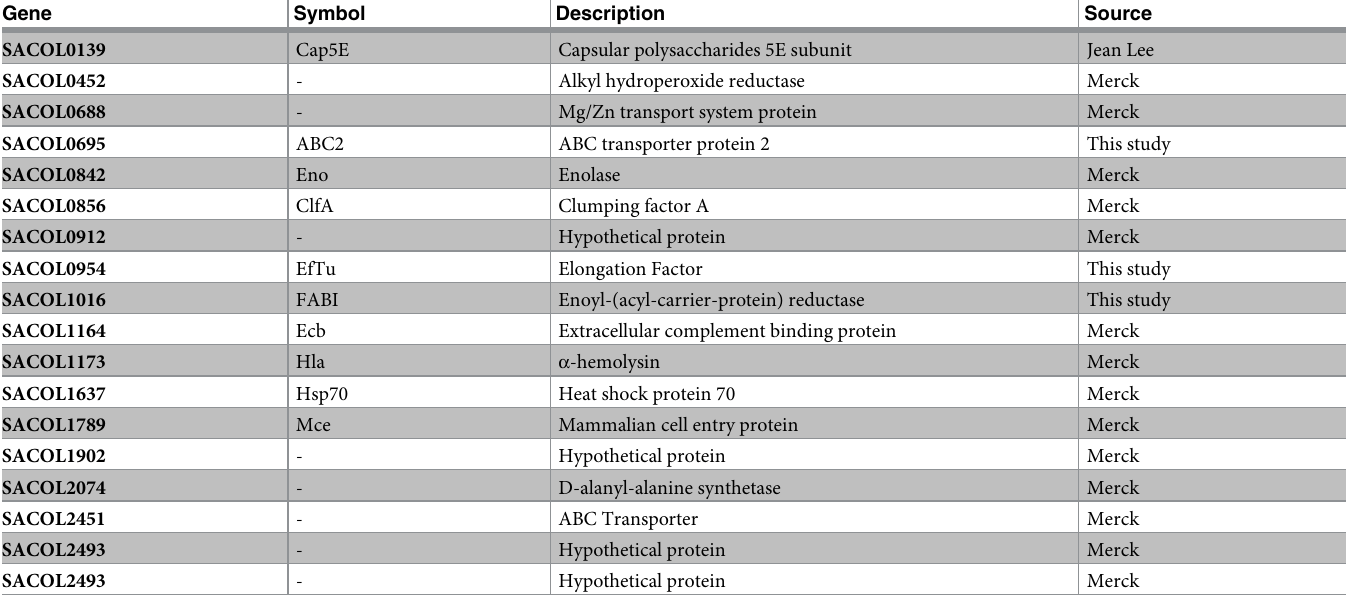
Table 2. Summary of the antigens